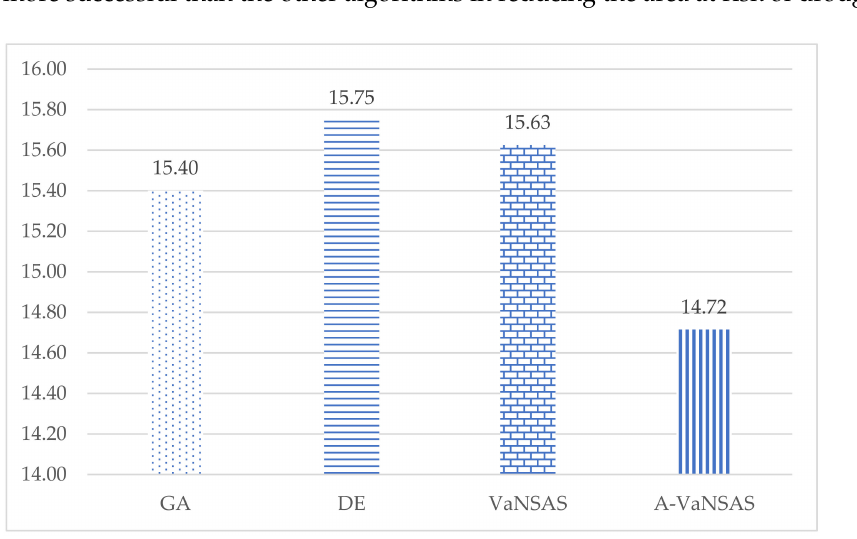
Figure 10. Construction cost per square meter to reduce drought risk using various methods